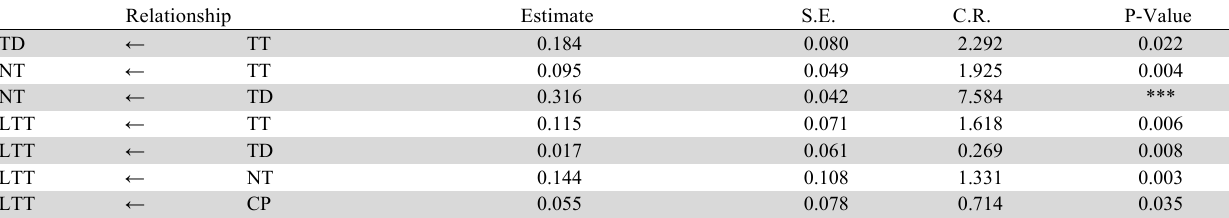
Results of the structural model